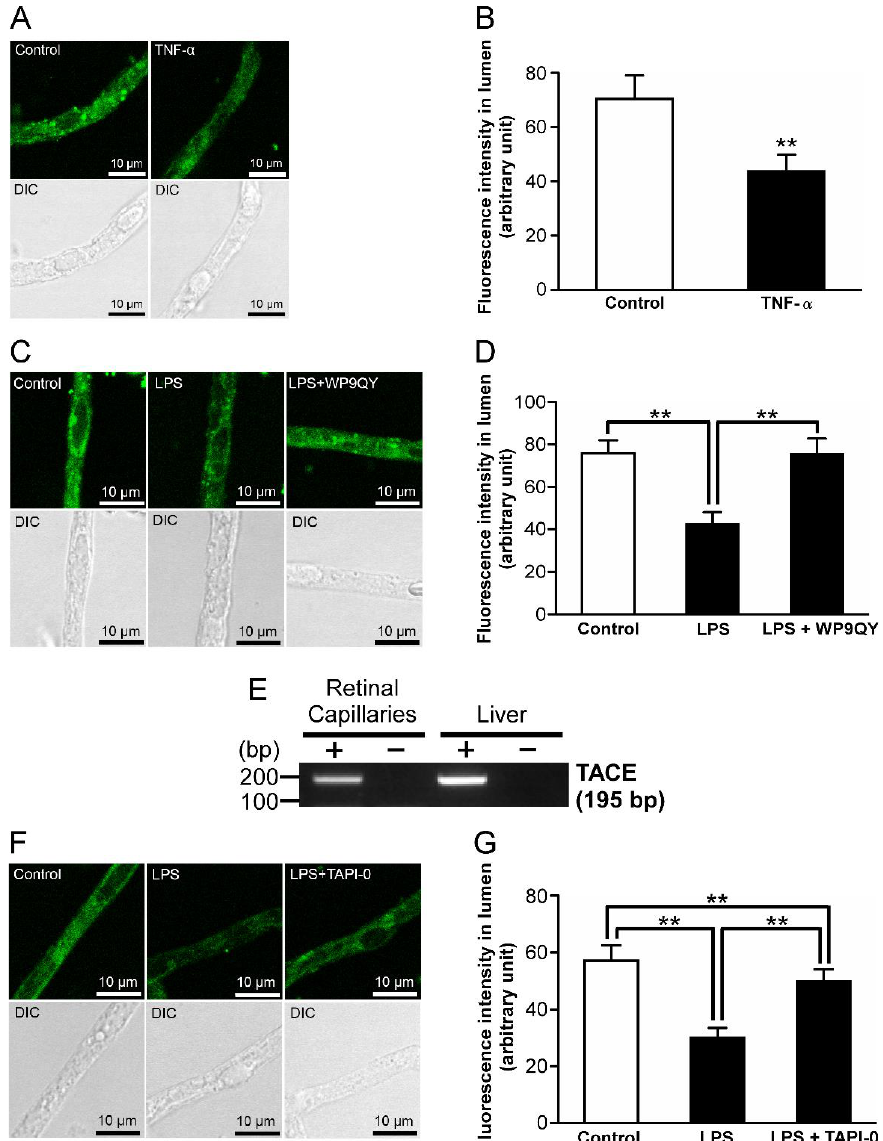
Figure 3. P-gp attenuation by tumor necrosis factor- α (TNF- α ) in the retinal capillaries under LPS- treated conditions. ( A , C , F ) Representative confocal images of isolated rat retinal capillaries after incubation with 4 µ M NBD-CSA for 60 min. ( A ) The capillaries were preincubated with ECF buffer in the absence (control) or presence of 1 ng/mL TNF- α for 30 min. ( C , F ) Capillaries were preincubated with 1 ng/mL LPS in the absence or presence of WP9QY (TNF- α antagonist) at 20 µ M or TAPI-0 (TACE inhibitor) at 400 nM for 30 min. ( B , D , G ) Quantification of NBD-CSA fluorescence in the lumens of retinal capillaries. ( E ) mRNA expression of TACE in rat retinal capillaries. RT-PCR analysis was performed in the presence (+) or absence ( − ) of reverse transcriptase using specific primers for TACE. The rat liver was used as the positive control. Each column represents the mean value for 10 capillaries from a single preparation; variability is given by S.D. bars. Units are expressed as arbitrary fluorescence (scale 0–255). ** p < 0.01, significantly different between the groups. Capillary images were captured using a